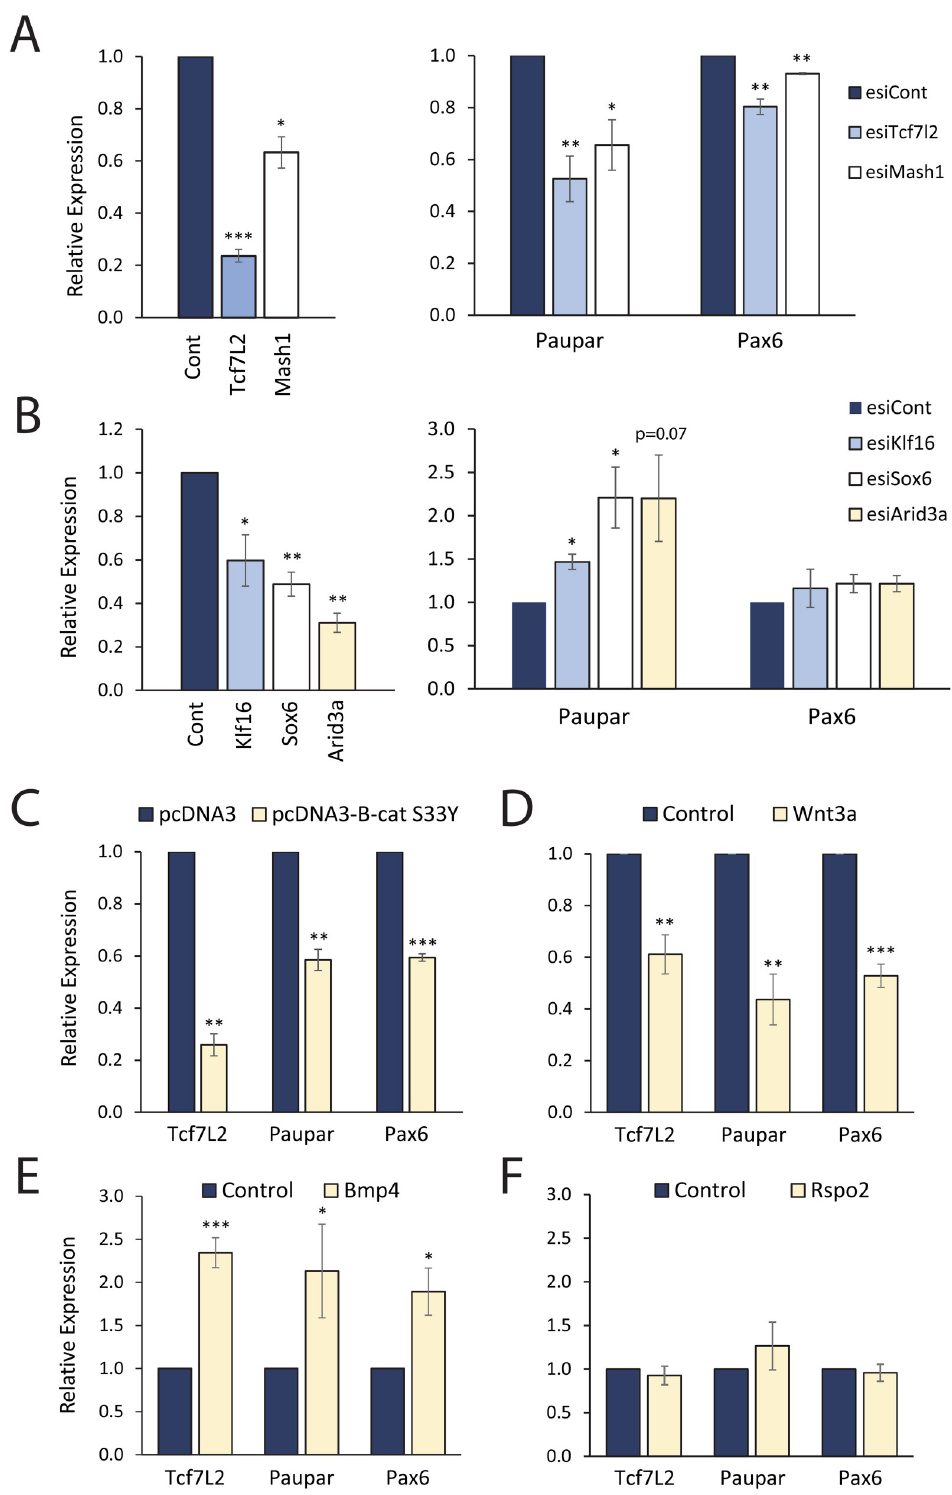
Fig 3. Identification of transcription factors and signalling pathways controlling Paupar-Pax6 expression in neuronal cells. (A) Tcf7L2 , Mash1 and (B) Klf16 , Sox6 and Arid3a expression were knocked-down in N2A cells